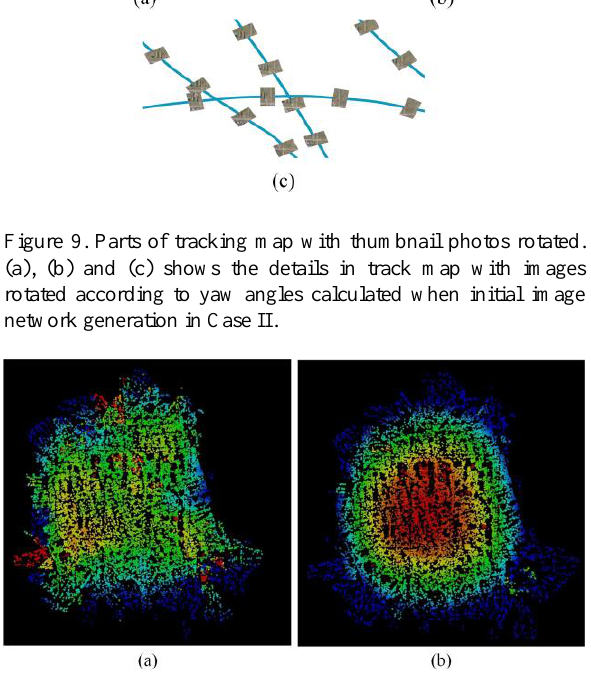
Figure 10. Point clouds. (a) and (b) show the point clouds before and after self-calibration bundle adjustment with GPS information of Case